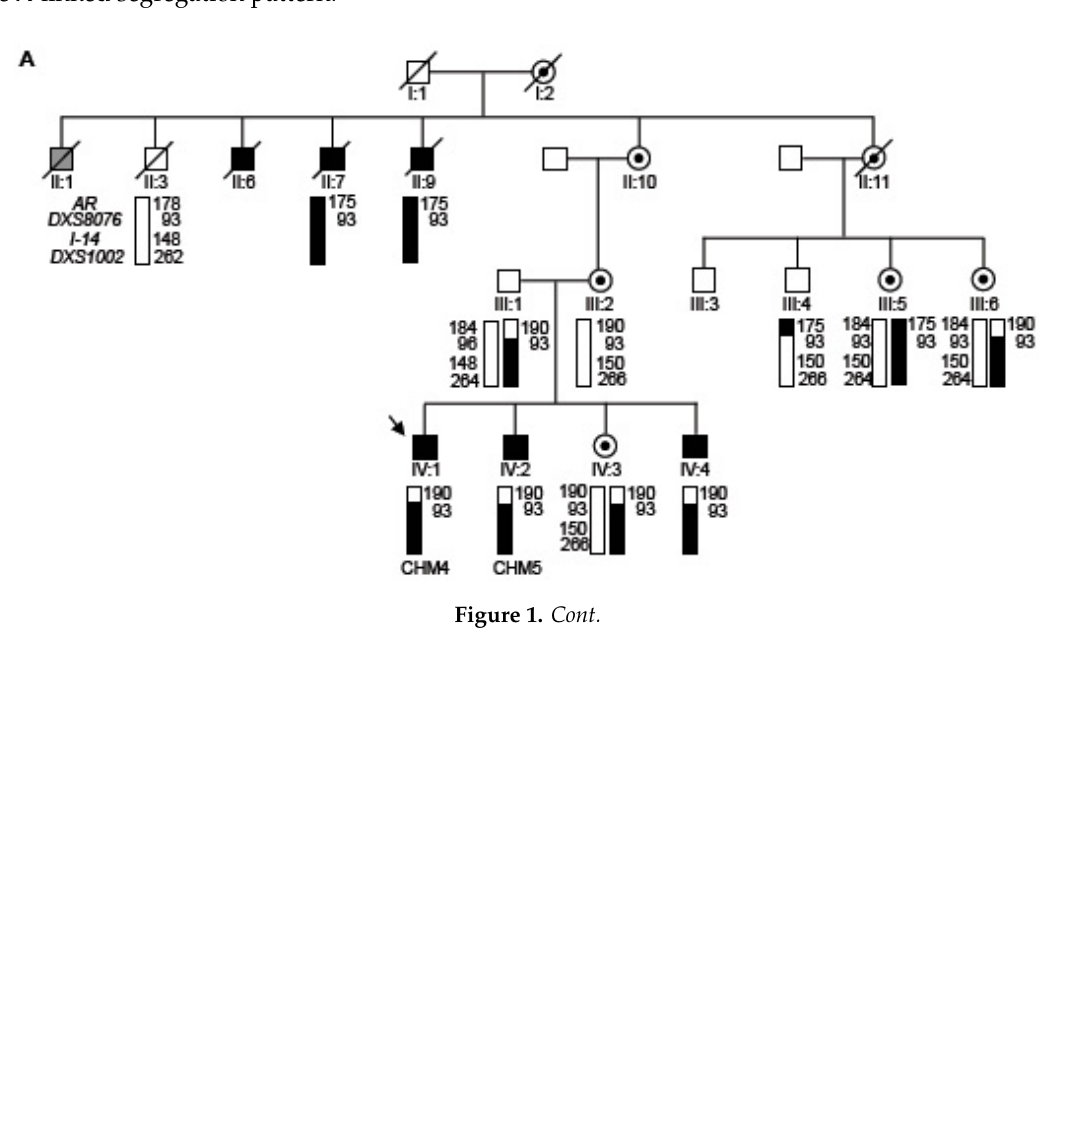
Figure 1. Family history and clinical phenotype . ( A ) Pedigree indicating males affected with choroideremia (filled symbols), carrier females (symbols with a dark dot) and unaffected individuals (open symbols). Diagonal lines indicate deceased individuals. In generation II, grey symbol indicates an individual who was reported as blind due to diabetes mellitus. The numbering of individuals in this generation is not continuous, as four additional siblings who died in childhood have not been indicated on the pedigree. The proband, (individual IV:1; CHM4) is indicated by an arrow. Disease-associated haplotypes are indicated by black rectangles and normal haplotypes by white rectangles. A recombination between the normal and CHM allele (black and white rectangles) appears to have occurred. AR — polymorphic marker in the gene encoding the androgen receptor. DXS8076 and DSX1002 — polymorphic markers flanking the CHM gene. I-14 — single tandem repeat in intron 14 of CHM. ( B ) Multimodal imaging of the right eye of the 18 year-old proband IV:1.